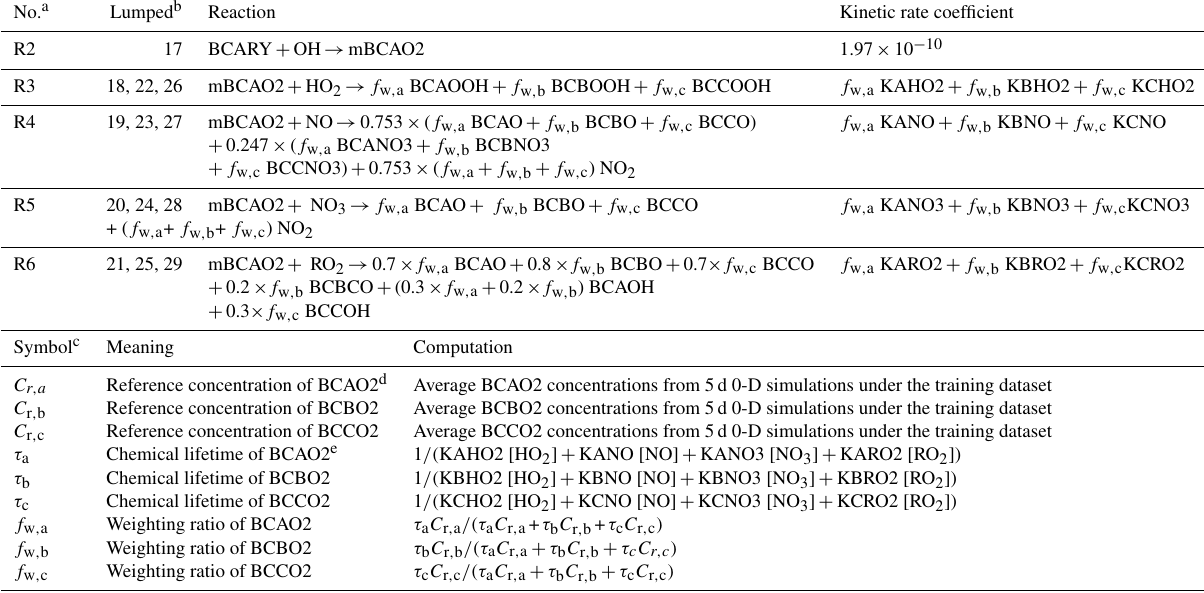
Table 4. Reduced reactions of Table 3 via the lumping strategy, in the case of lumping BCAO2, BCBO2, and BCCO2 into a new surrogate mBCAO2. The name of the new surrogate contains the letter “m” for “merged” and the name of the relatively dominant lumped species. This notation of lumping is used